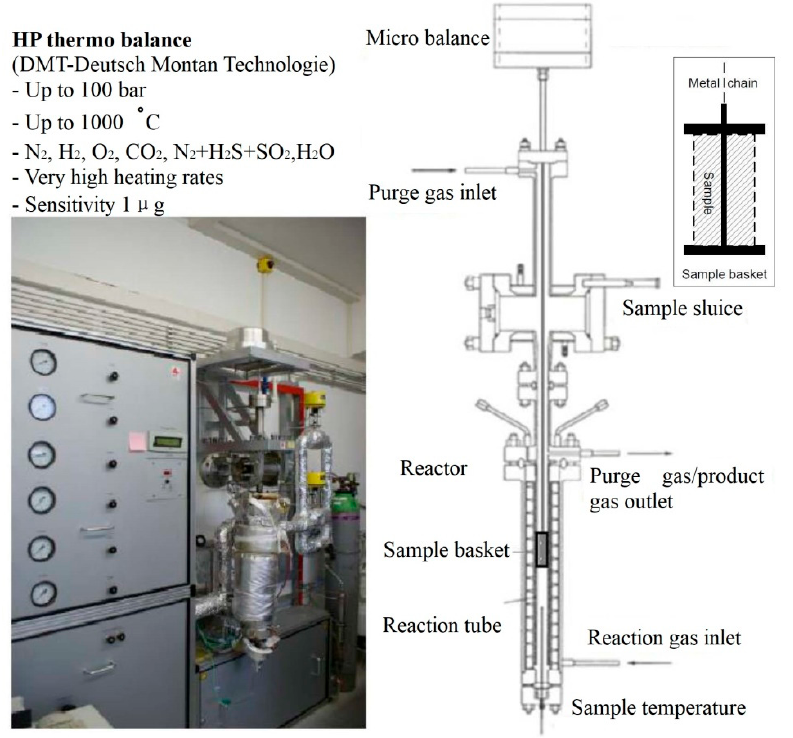
Figure 1. Schematic of thermogravimetric analyzer (TGA).